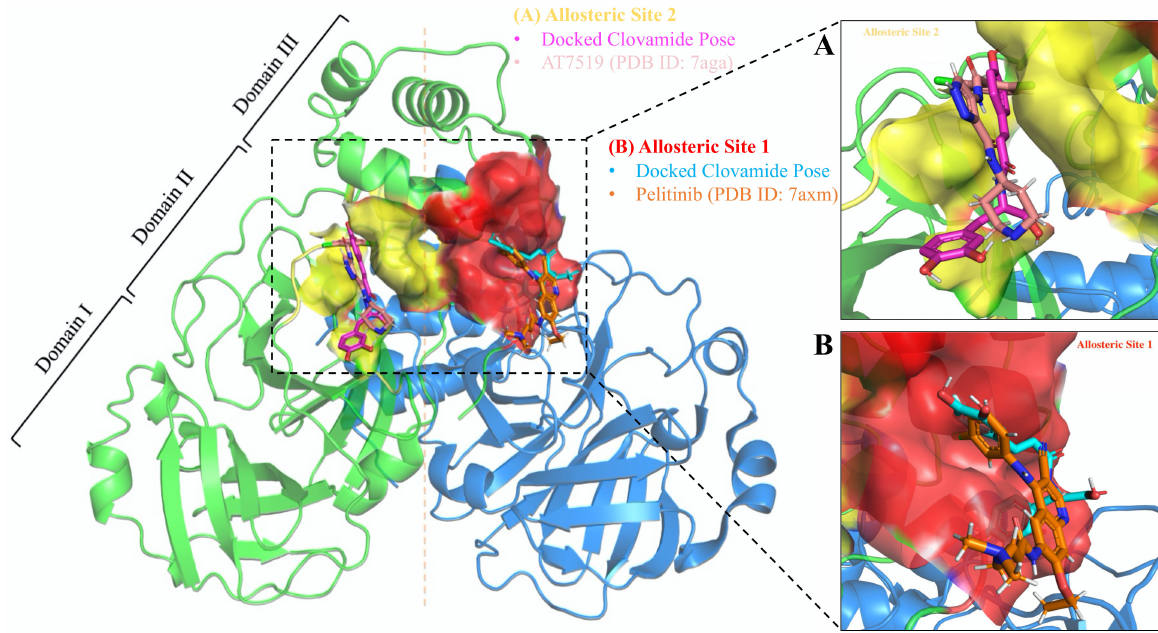
Figure 10. Allosteric sites of SARS-CoV-2 M pro in complex with inhibitors. Shown on the left is a view of the protease homodimer, with one protomer colored in green and other in navy [6]. The vertical orange dashed line indicates the C2 symmetrical axis. Each protomer can be divided into three domains, and the allosteric site binding pockets are located, respectively, at domain III (site 1, red) and in between domain II and III (site 2, yellow) [57]. ( A ) Shows the allosteric site 2, with the bound AT7519 crystal structure (PDB: 7AGA), and the docked clovamide pose; ( B ) shows the allosteric site 1 with bound inhibitor Pelitinib crystal structure (PDB: 7AXM) and the docked clovamide pose in this allosteric site. See legends in the Figure for color